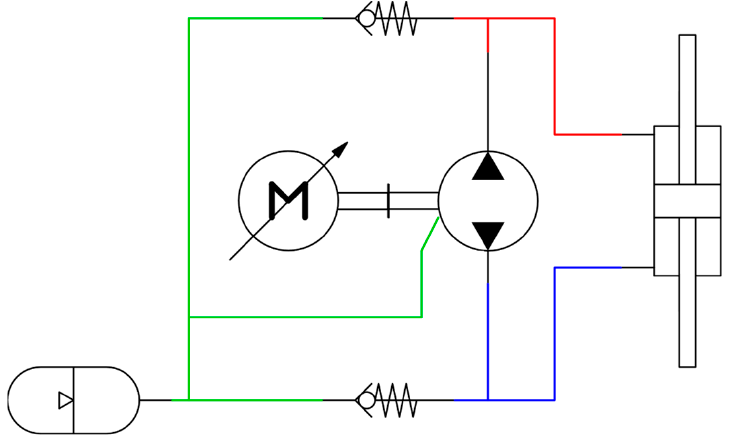
Figure 2. Hydraulic diagram of the EHA.